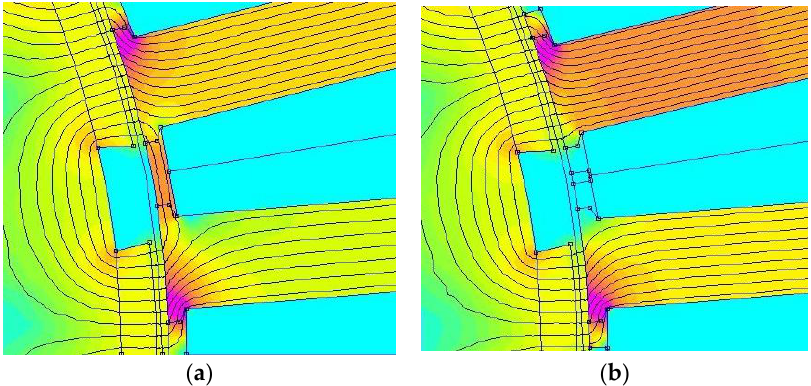
Figure 4. Magnetic field lines ( θ = 0°): ( a ) Model with closed slots; ( b ) Model with pre-slots.